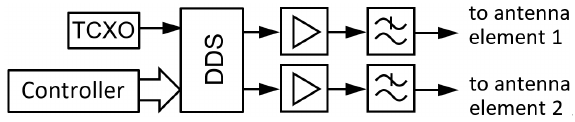
Figure 6. The block diagram of the probe signal transmitter.